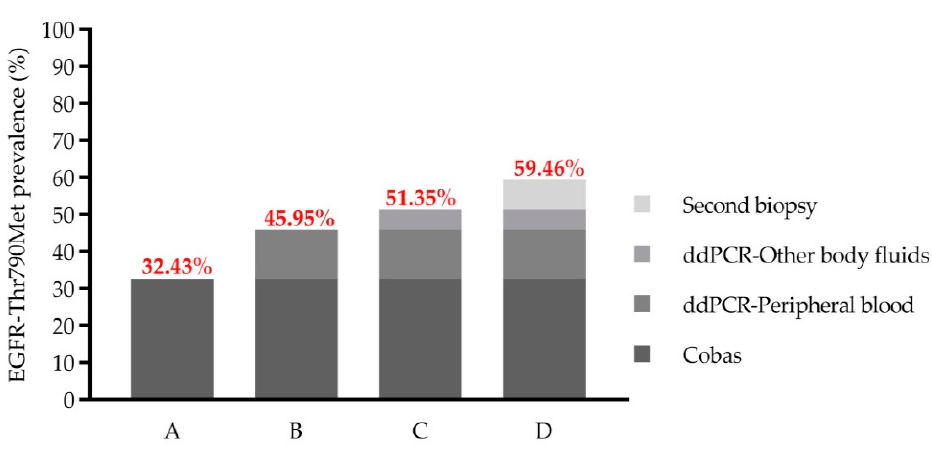
Figure 4. Increase in EGFR-Thr790Met prevalence at the time of disease progression according to different testing strategies. A: Cobas ® , B: ddPCR—peripheral blood, C: ddPCR—peripheral blood + ddPCR—other body fluids and D: Strategy C + second tissue biopsies. Prevalence obtained with each strategy is depicted.